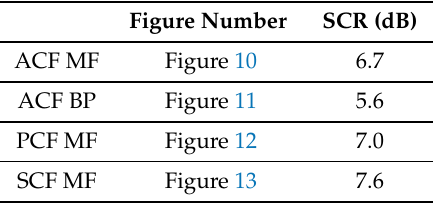
Figure 13. MF image of Figure 5 corrected via sign coherence factor (SCF). Table 4. SCR for six-aperture images after CF-based